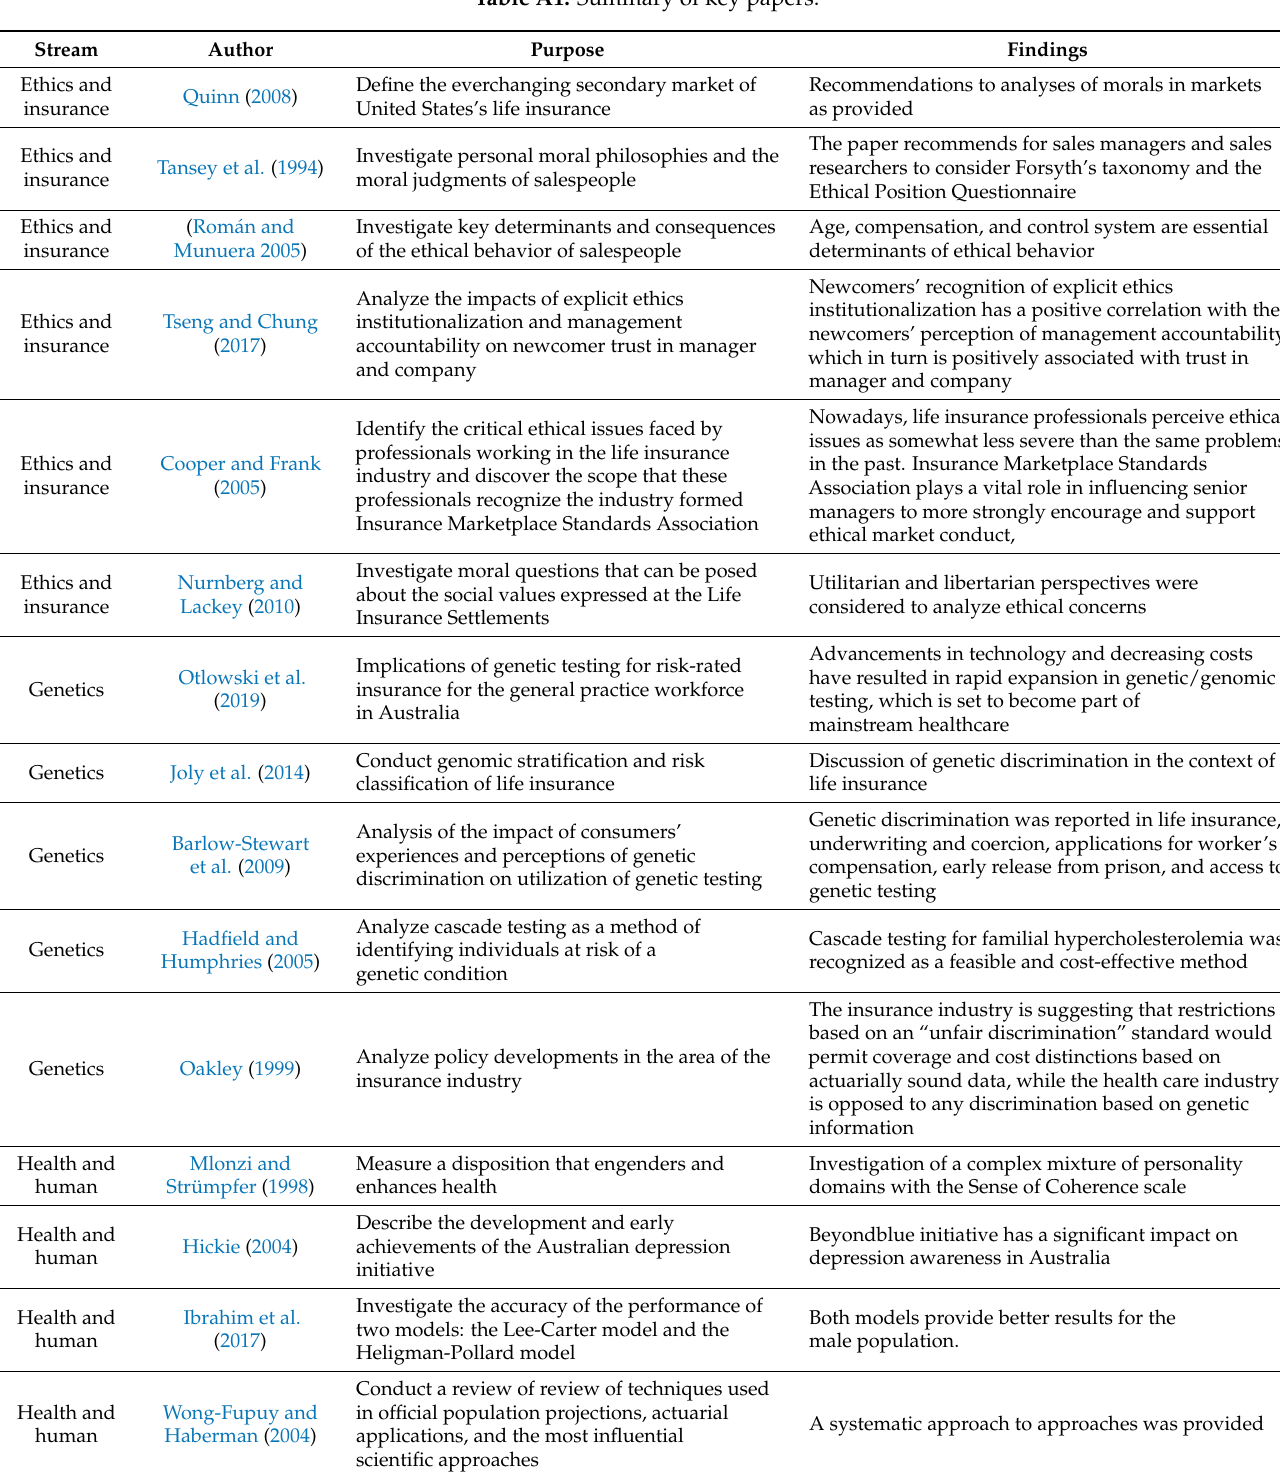
Table A1. Summary of key